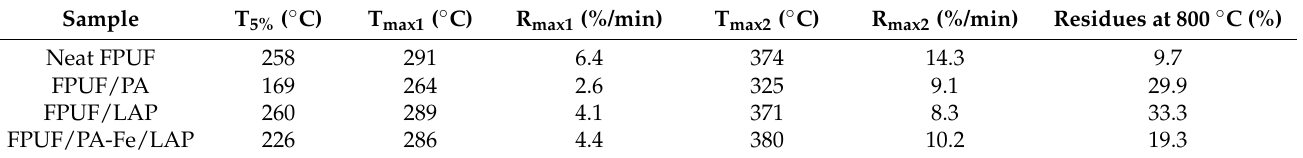
Figure 2. TG ( a ) and DTG ( b ) curves of neat FPUF, FPUF/PA, FPUF/LAP, and FPUF/PA-Fe/LAP in N 2 . Table 1. Summary of TG data for neat FPUF, FPUF/PA, FPUF/LAP, and FPUF/PA-Fe/LAP in N 2 .